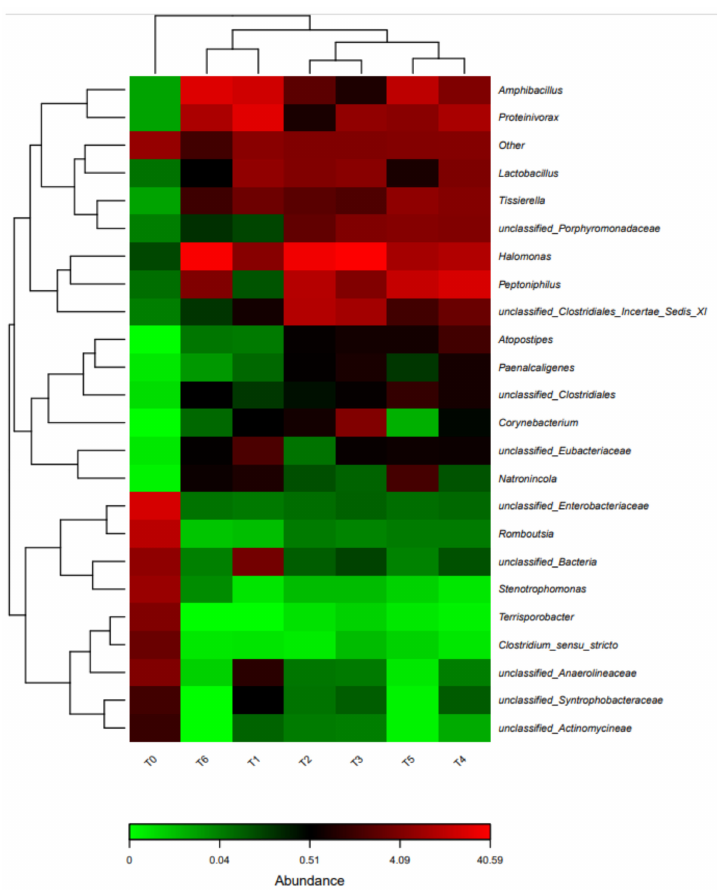
Figure 5. Bacterial community distribution at the genus